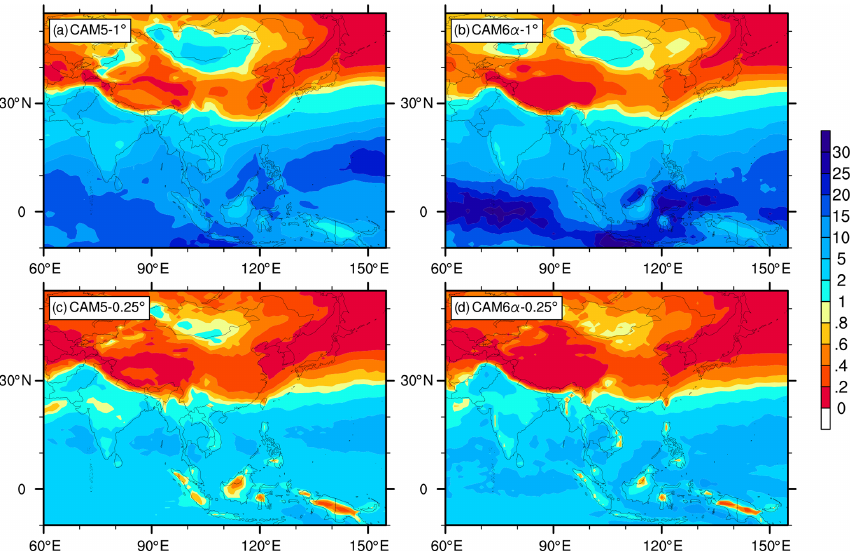
Figure 4. The 1980–2004 convective to large-scale precipitation ratio (unitless) for (a) CAM5-1 ◦ , (b) CAM6 α -1 ◦ , (c) CAM5-0.25 ◦ and (d) CAM6 α -0.25 ◦